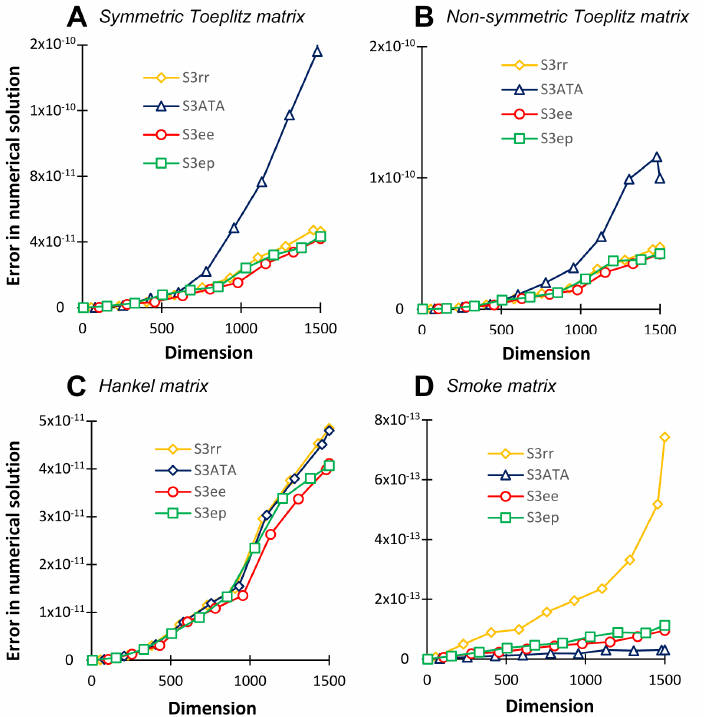
Figure 6. Comparative analysis of the four variants of the orthogonally scaled complex ABS algorithm on selected Matlab Gallery problems.